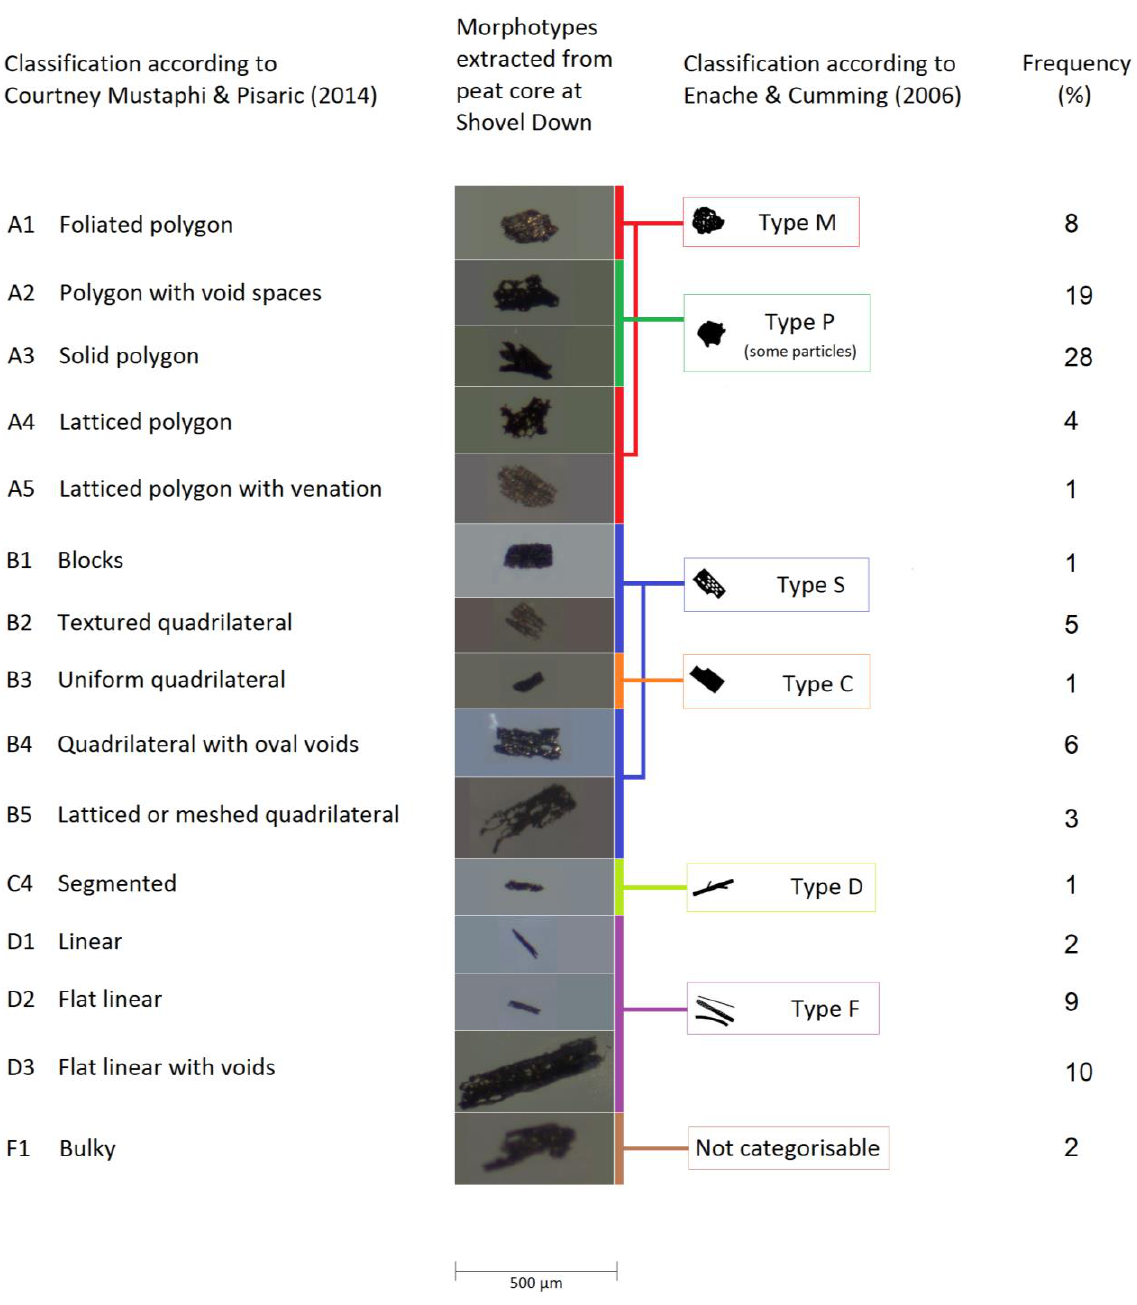
Figure 6. Charcoal morphotypes from the Shovel Down peat core categorised according to published classification schemes, including comparative images from Enache & Cumming (2006). For copyright reasons, readers are referred to Courtney Mustaphi & Pisaric (2014) for comparative images from that classification